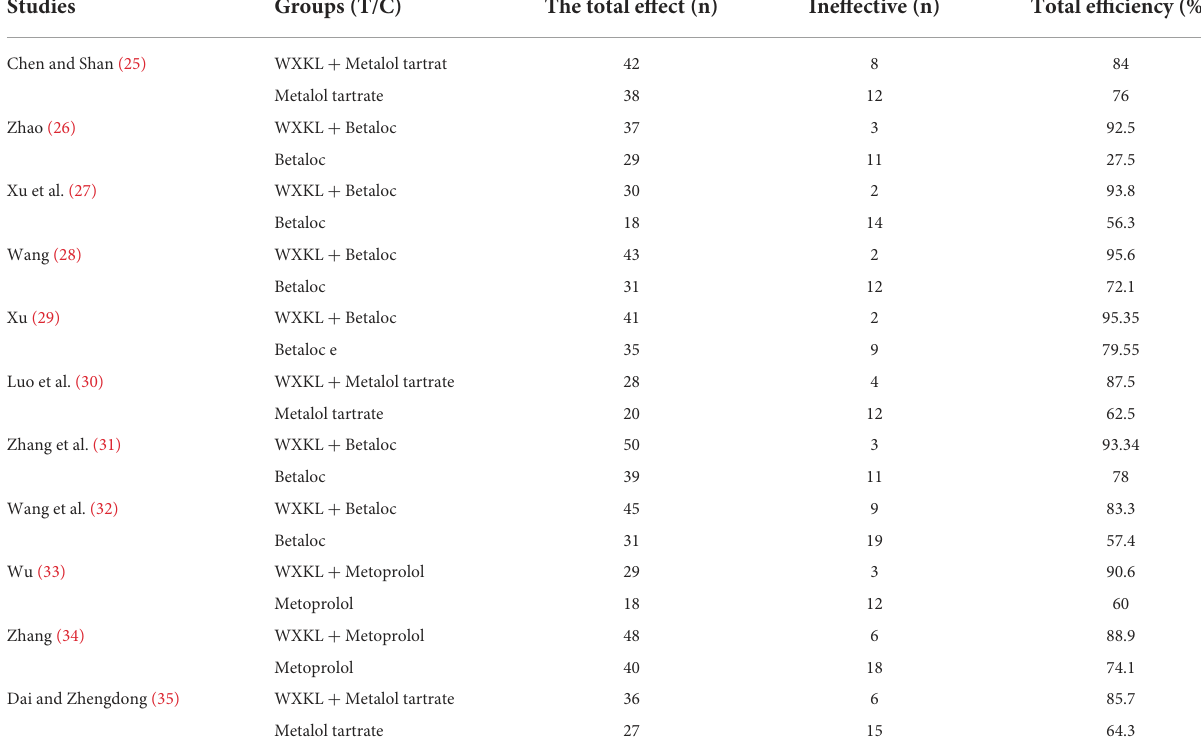
TABLE 4 The frequency improvement effect of VPCs within